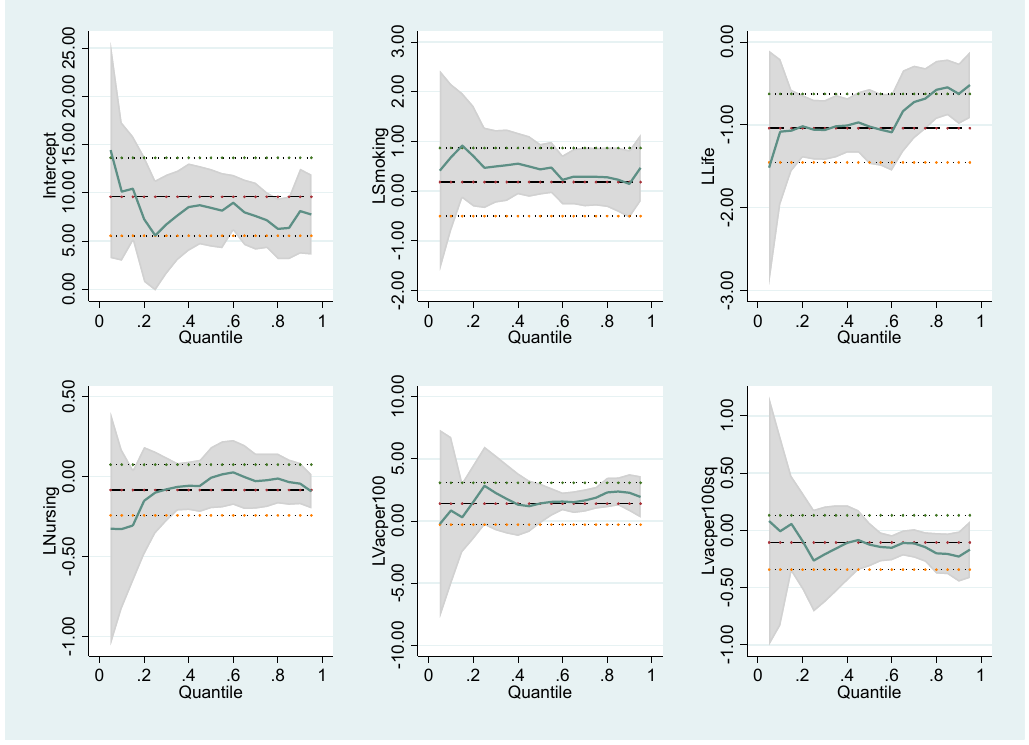
Figure 2. Changes in the quantile regression coefficients for Model II. Notes: The shaded bands represent the corresponding 95% confidence intervals.